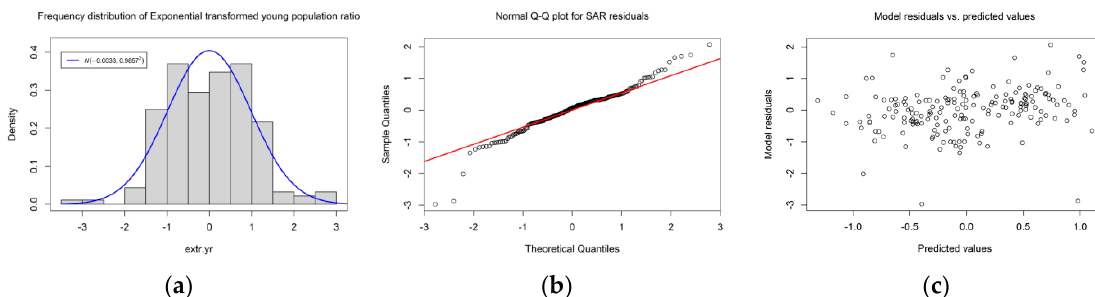
Figure A9. Statistical properties of the transformed young population ratio and its regression residuals: ( a ) a histogram of the exponential transformed young population ratio; ( b ) a Q-Q plot of the SAR model residuals; and, ( c ) a scatter plot of residual-predicted values for assessing the homoscedasticity of model residuals.